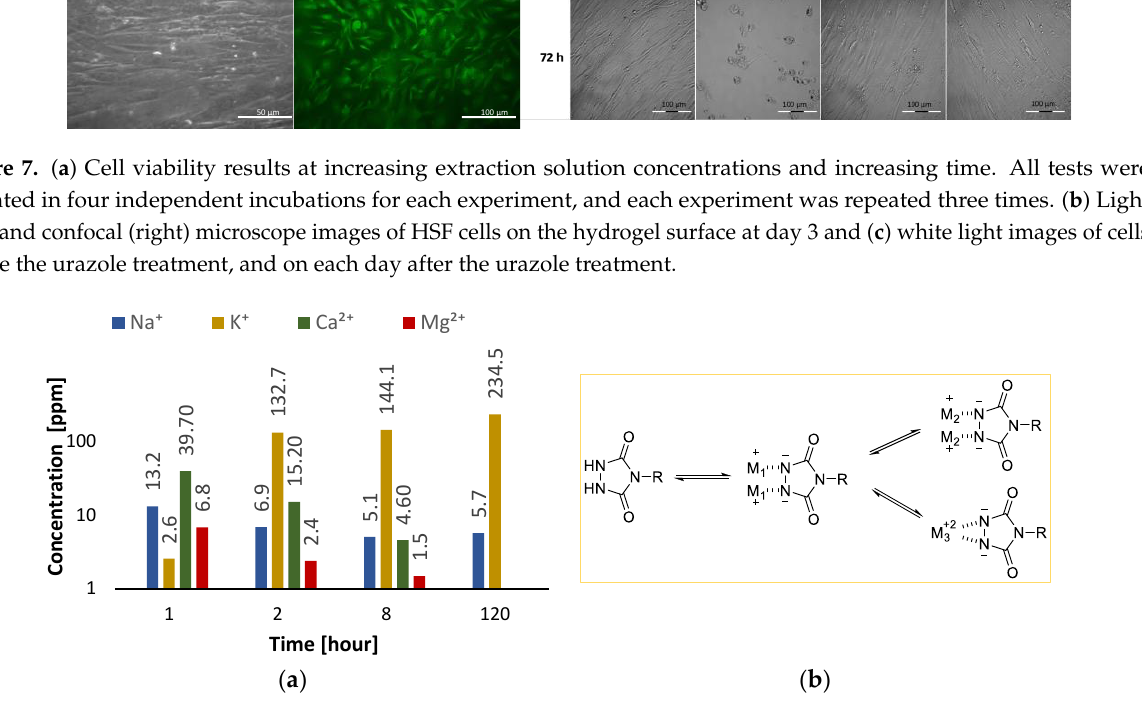
Figure 7. ( a ) Cell viability results at increasing extraction solution concentrations and increasing time. All tests were re- peated in four independent incubations for each experiment, and each experiment was repeated three times. ( b ) Light (left) and confocal (right) microscope images of HSF cells on the hydrogel surface at day 3 and ( c ) white light images of cells before the urazole treatment, and on each day after the urazole treatment.